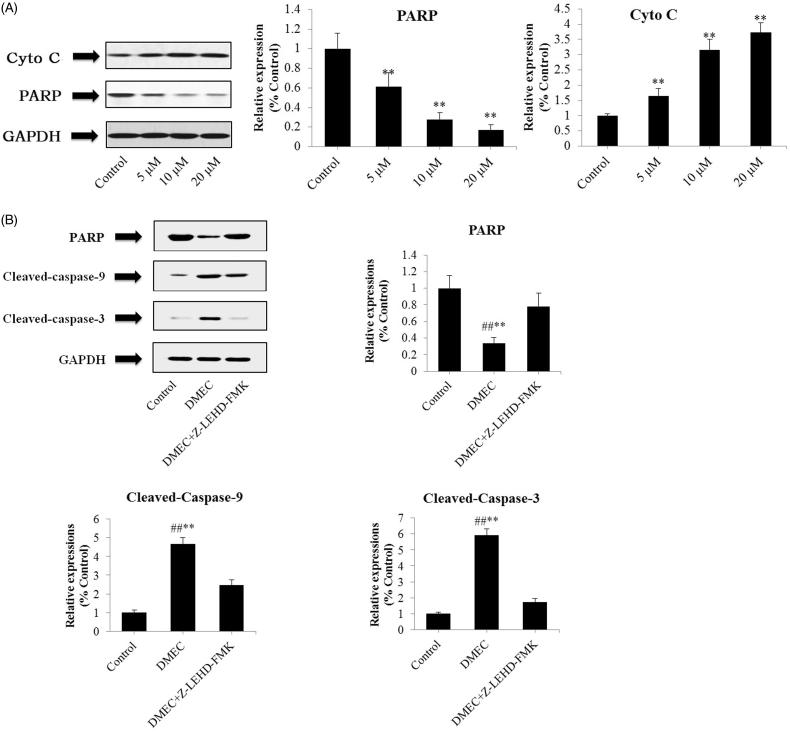
DMEC induced mitochondria-mediated apoptosis in MM cells (A) U266 cells were treated with DMEC (5, 10, and 20 μM) for 24 h, and protein expression levels of Cyto C and PARP were determined by western blot analysis. (B) U266 cells were treated with Z-LEHD-FMK (20 μM) for 1 h, followed by co-culture with 20 μM DMEC. Protein expression levels were determined by western blot analysis with the antibodies against PARP, C-3 and C-9. Data are presented as the mean ± standard deviation (n = 4). **p < 0.01 vs. control group; ##p < 0.01 vs. DMEC + Z-LEHD-FMK group.